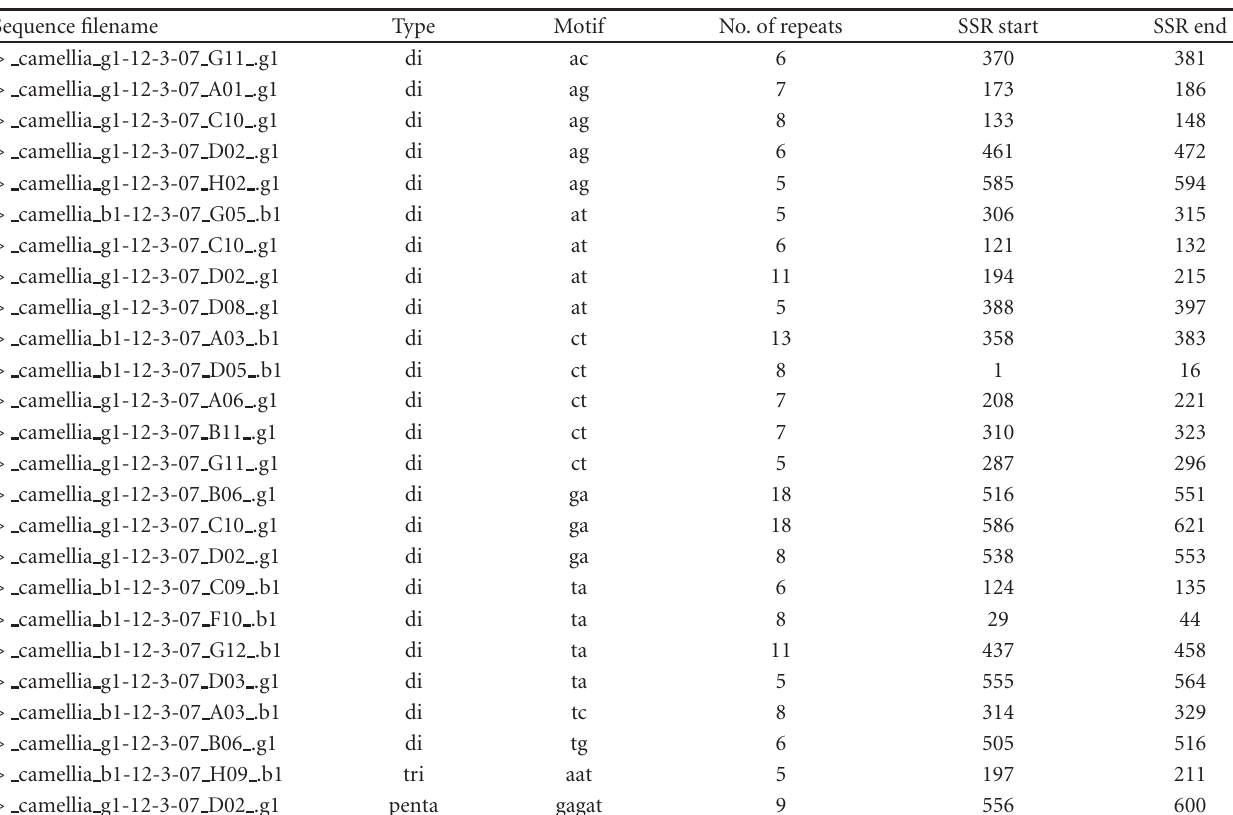
Table 3: Identification of simple sequence repeats (SSRs)from preliminary BAC-end sequence (BES) of the Camellia sinensis tea BAC library, CSBCBa. Sequence